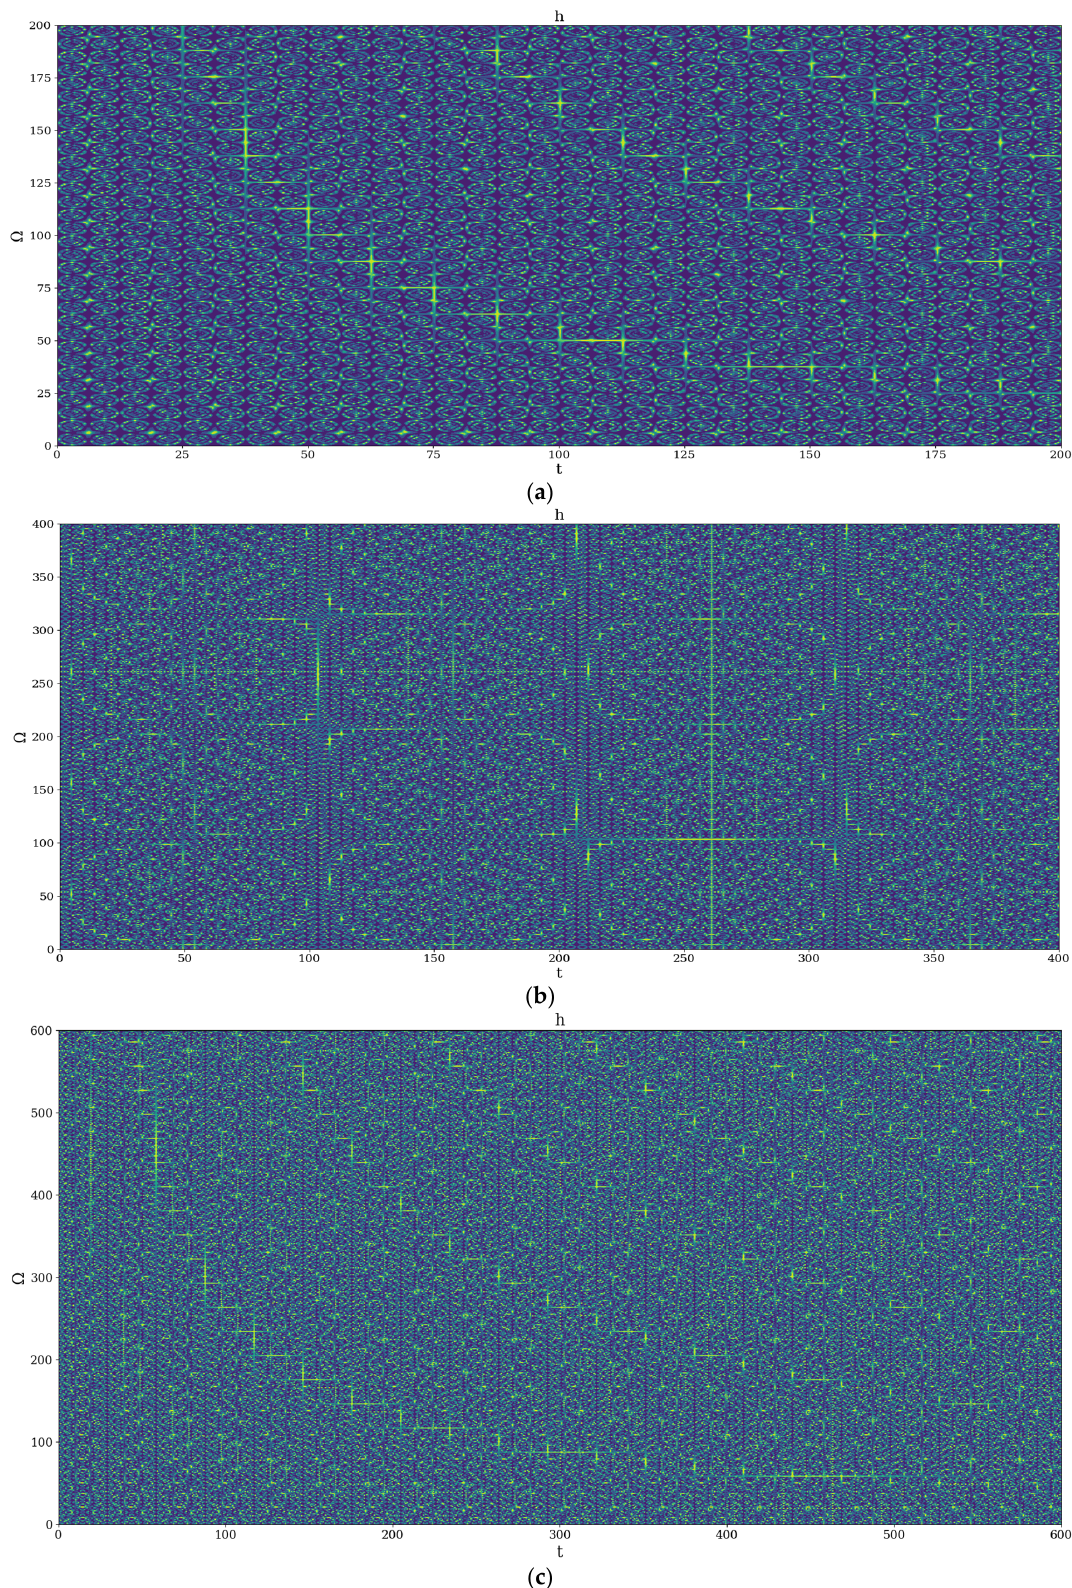
Figure 10. ( a ): Example of 2D plot fracture patterns by means of h ( Ω , t ) , maximum at 200; Φ = 2.35. ( b ): Example of 2D plot fracture patterns by means of h ( Ω , t ) , maximum at 400; Φ = 2.35. ( c ): Example of 2D plot fracture patterns by means of h ( Ω , t ) , maximum at 600; Φ =